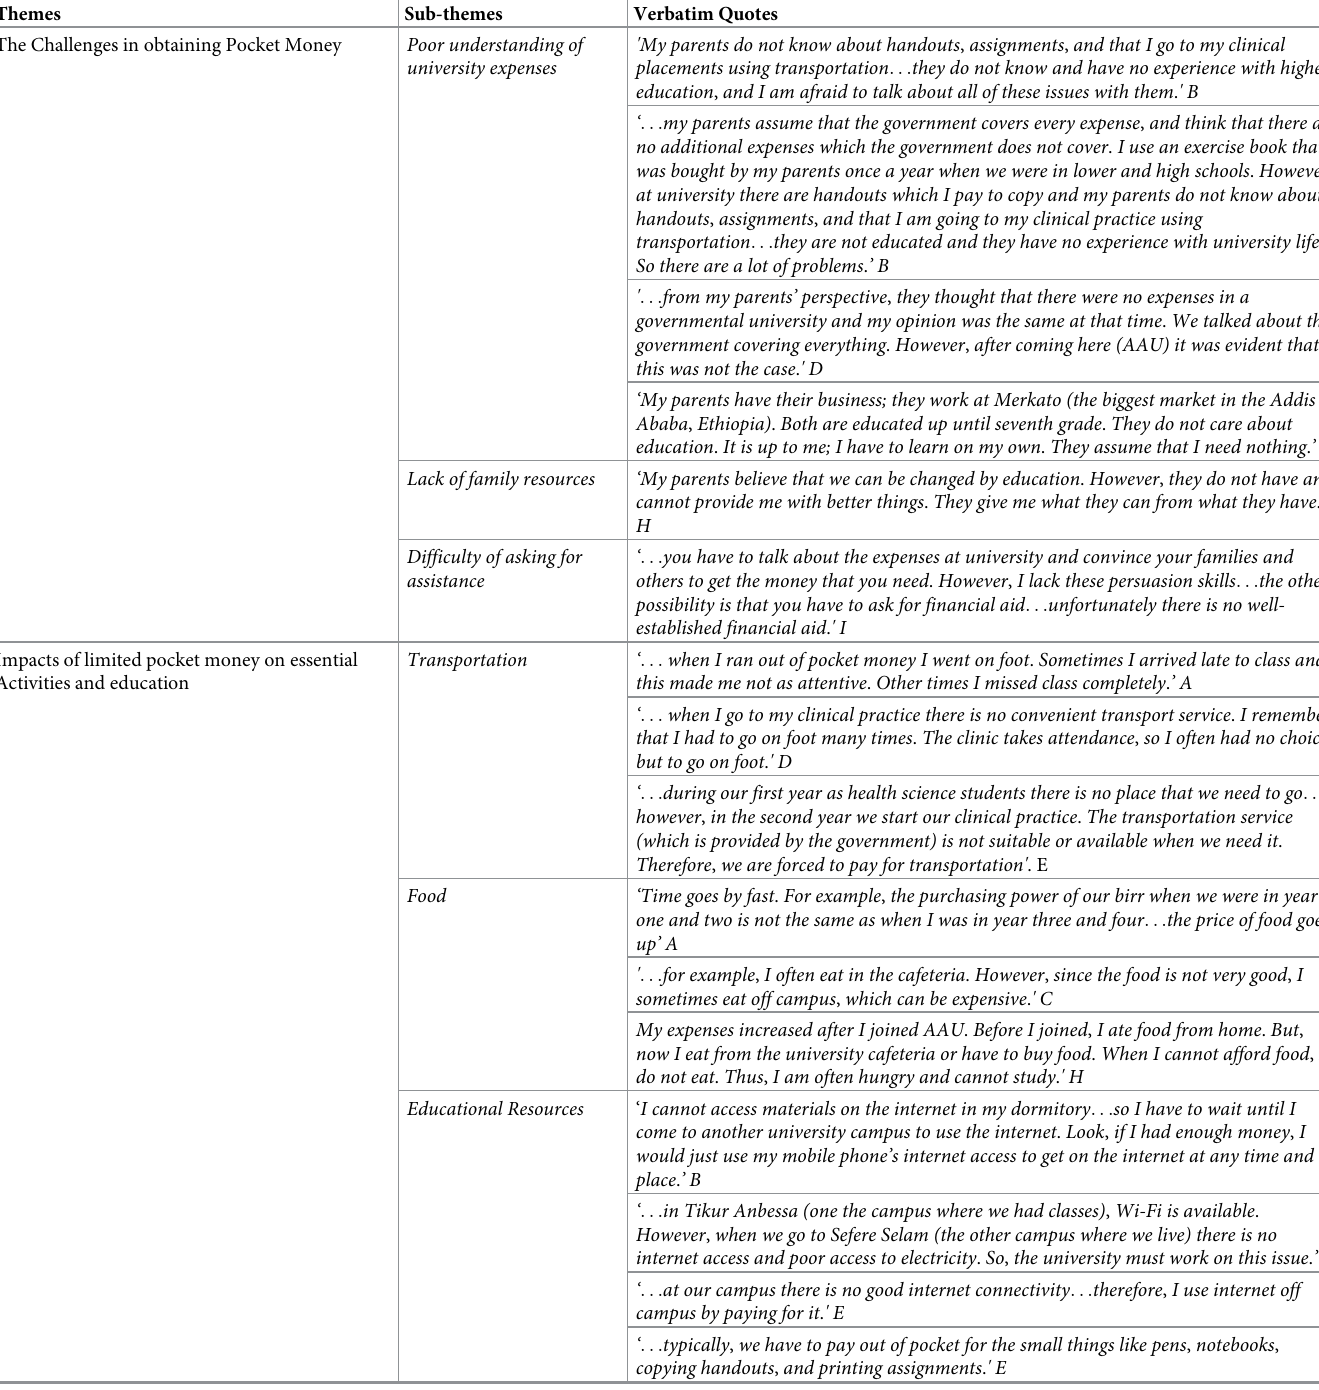
Table 2. Representative quotes, within the four identified themes, from health sciences students at Addis Ababa University regarding the effects of a lack of pocket money on